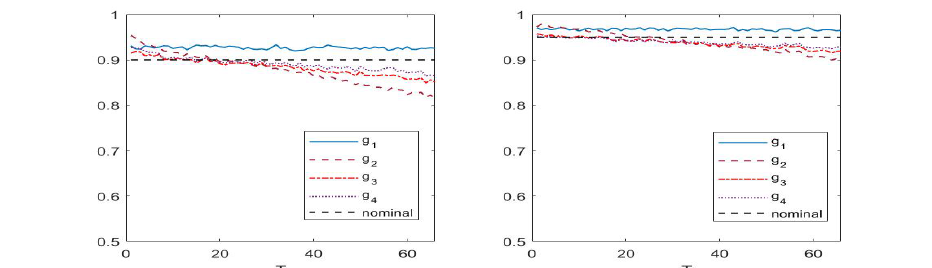
Figure 1. The converge rates of five test statistics under H 0 , against the length of time interval T . ( Left ): a 90% nominal level. ( Right ): a 95% nominal level.